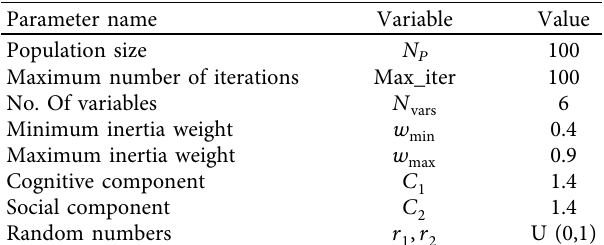
Figure 7: PSO flowchart [45]. Table 4: PSO parameters [45].